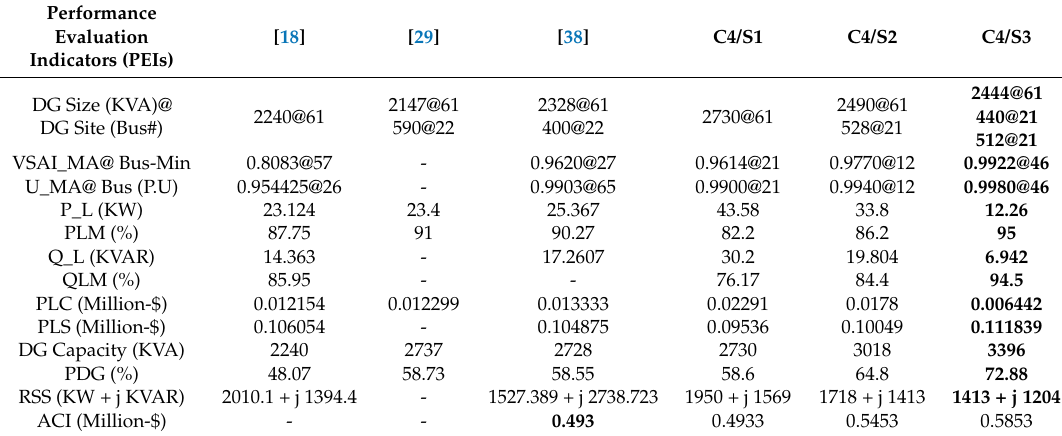
Table 10. Comparisons of results with various scenarios of Case 4 for 69-Bus test system (DG @ pf = 0.82 ±